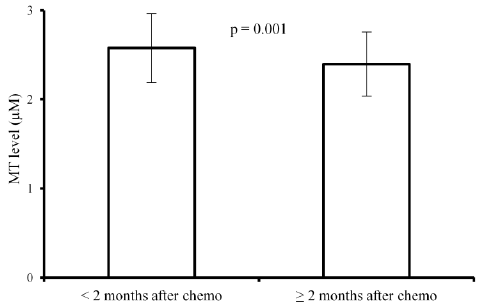
Figure 3. MT levels/mean ± s.d./in group of patients <2 months after finishing chemotherapy compared to patients ≥ 2 months after finishing chemotherapy [paired T -test ( t = 3.53, df = 75) p =